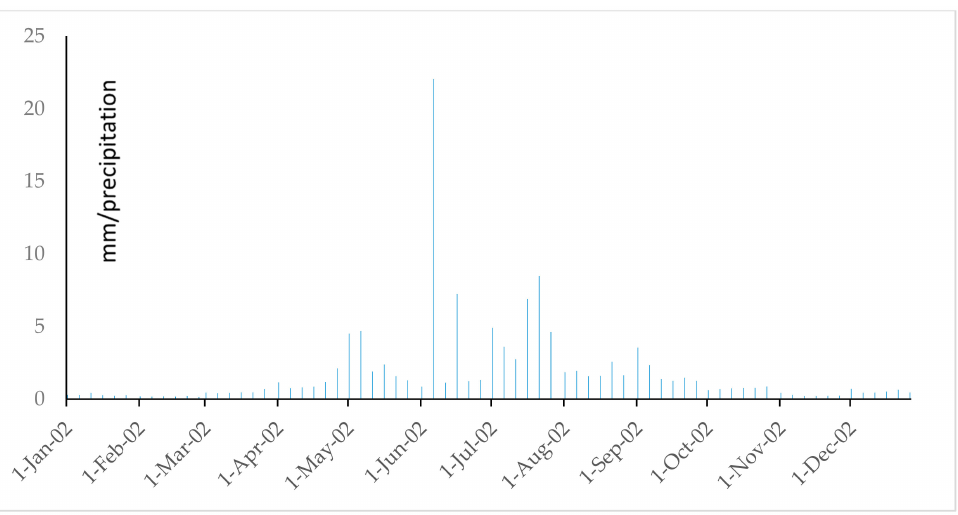
Figure A30. Precipitation of Denko County in